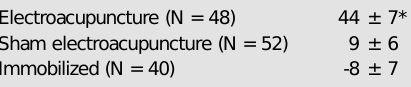
Figure 1. Photograph depicting the precise location of needle insertion in a group I animal (elec- troacupuncture). The needle (see insertion marked with a black dot) at the most distal part of the hind limb corresponds to point SP-6 ( Sanyinjiao ) and the more proximal needle (see black dot) corresponds to ST-36 ( Zusanli ). White dots correspond to stimu- lation points used for the sham group (group II).